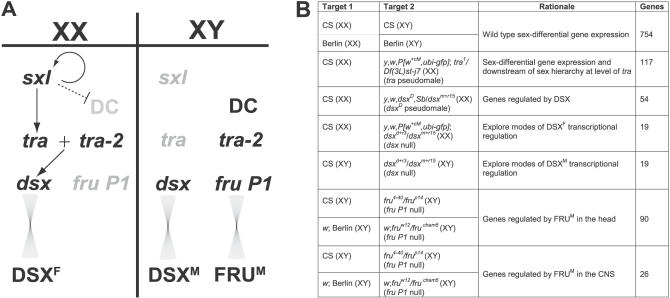
The Sex Determination Hierarchy and Microarray Experimental Overview(A) The Drosophila sex determination hierarchy consists of an alternative pre-mRNA splicing cascade, culminating in the production of sex-specific transcription factors encoded by dsx and fru P1. In Drosophila, the primary determinant of sex is the X chromosome to autosome ratio. In females, this ratio is one and leads to the production of SXL. sxl, tra, and tra-2 encode pre-mRNA splicing factors. SXL regulates sxl and tra pre-mRNA splicing, resulting in the production of TRA in females. TRA together with TRA-2 regulates the splicing of dsx and fru P1 pre-mRNAs. In males, dsx and fru P1 are spliced by the default pathway. Arrows indicate regulation of pre-mRNA splicing, and hourglass shapes indicate translation. The dotted line indicates inhibition of the dosage compensation (DC) pathway.(B) Experimental overview for microarray comparisons. The genotypes and phenotypes of animals from which the microarray probe pairs are derived are indicated in columns with headings Target 1 and Target 2. For each genotype, the chromosomal sex is shown in parentheses. The rationale for the experimental comparison is indicated. The number of genes that met the statistical criteria (see text) is indicated in the column with heading “Genes.”doi:0.1371/journal.pgen.0030216.g001